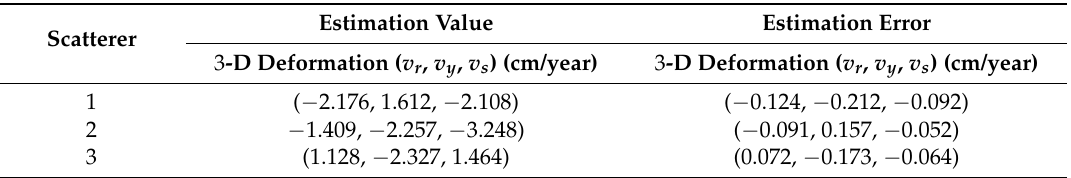
Table 9. Estimation of 3-D deformation velocity of three scatterers in large diversity of squint angles between two sets of SAR